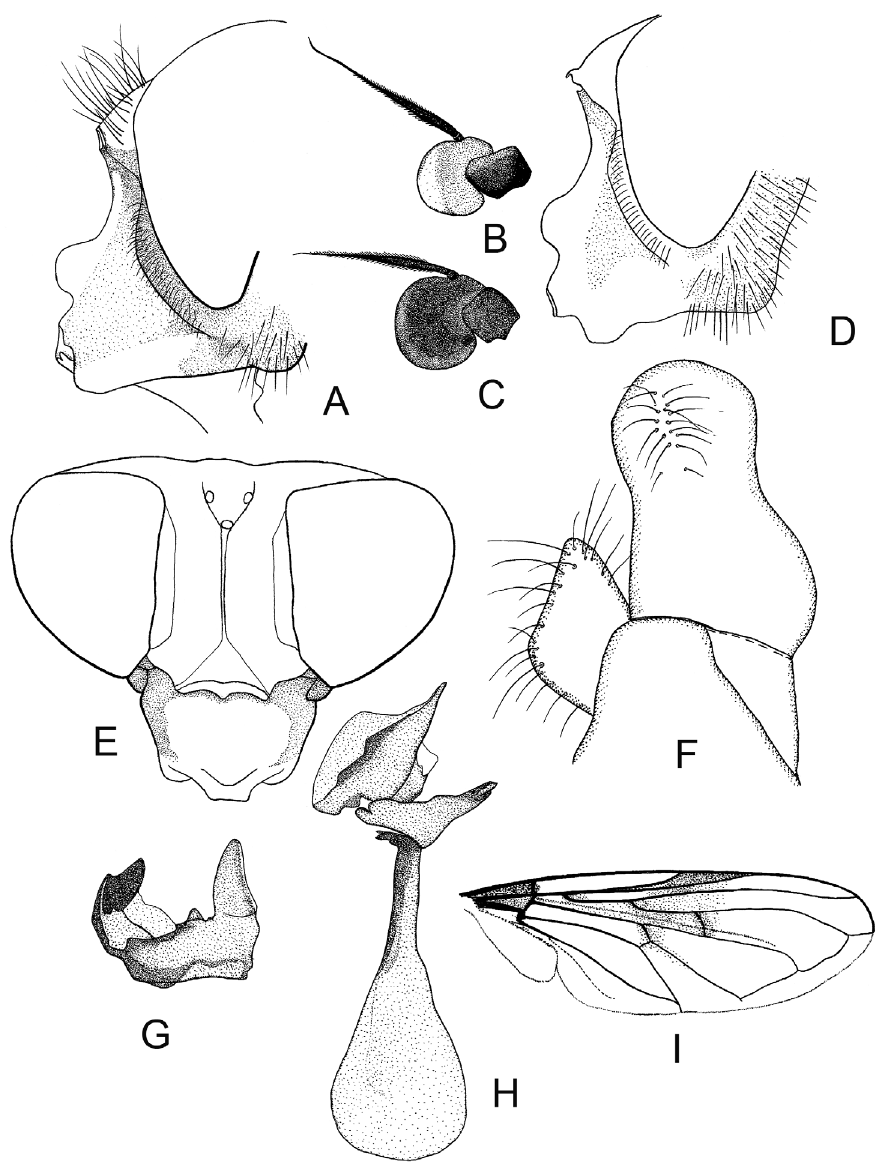
Figure 11. Cheilosia venosa Loew. A Male head, lateral view B Antenna of male, lateral view C Antenna of female, lateral view D Female head, lateral view E Female head dorsal view F–H male genitalia, lateral, from left to right: F Cercus+surstylus G Superior lobe H Aedeagal complex I Male, wing. pollinosity (Fig. 11A). Facial knob prominent (nose-like). Parafacia with pollinosity, on lower part shining patch, slightly more than 1/2 the width of basoflagellomere. Frons shining, rather swollen, with black and white pile. Frontal angle ≈ 90°.